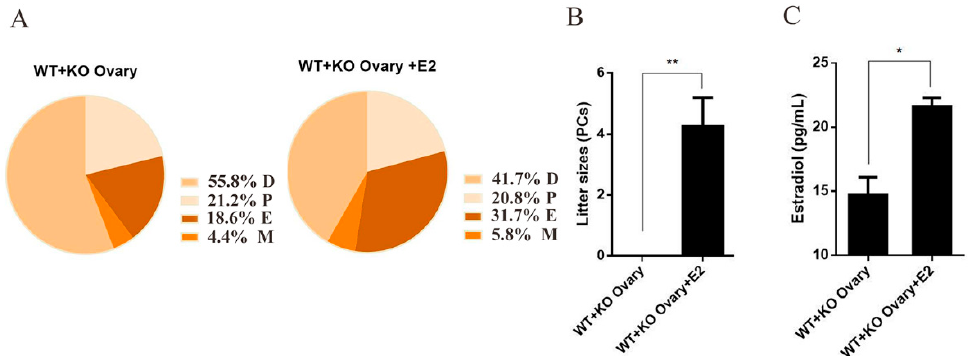
Figure 5. Estrogen reverses the infertility of female mice caused by miR-7a2 deletion. ( A ) The estrus cycle of transplanted model mice was determined by a vaginal smear for 18 consecutive days, comprising the diestrus, proestrus, estrus, and metestrus stages represented by D, P, E, and M, respectively ( n = 4). ( B ) “WT + KO Ovary” mice and “WT + KO Ovary + E 2 “ mice were separately mated with WT male mice for 3 weeks, and the litter sizes were recorded ( n = 4). ( C ) Detection of estrogen levels in the serum of ovarian transplanted mice ( n = 4). Data are presented as mean ± SEM. * p < 0.05. ** p < 0.01.